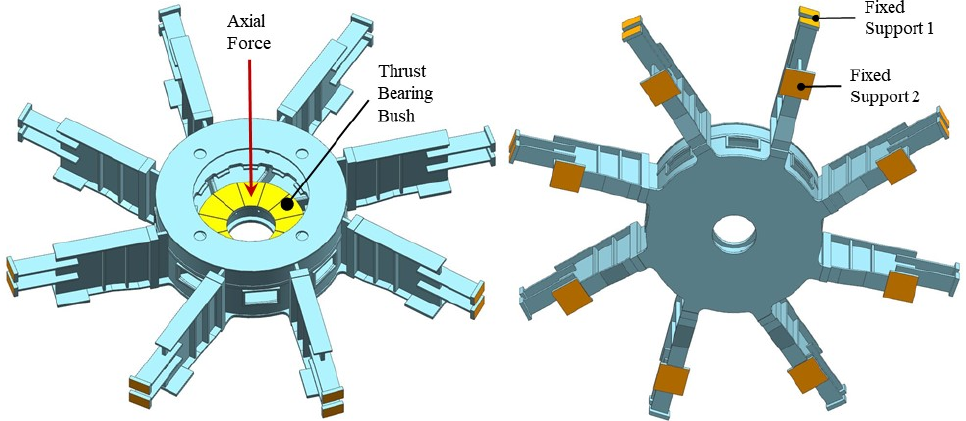
Figure 7. The three-dimensional model of the support bracket.